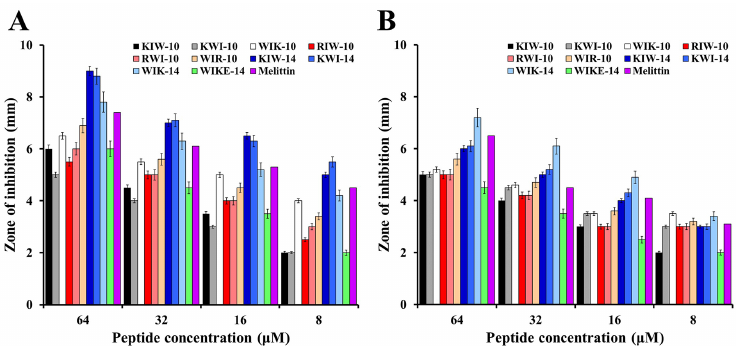
Figure 3. Antibacterial activity of peptides against E. coli ( A ) and S. aureus ( B ) determined with the agar-diffusion assay.